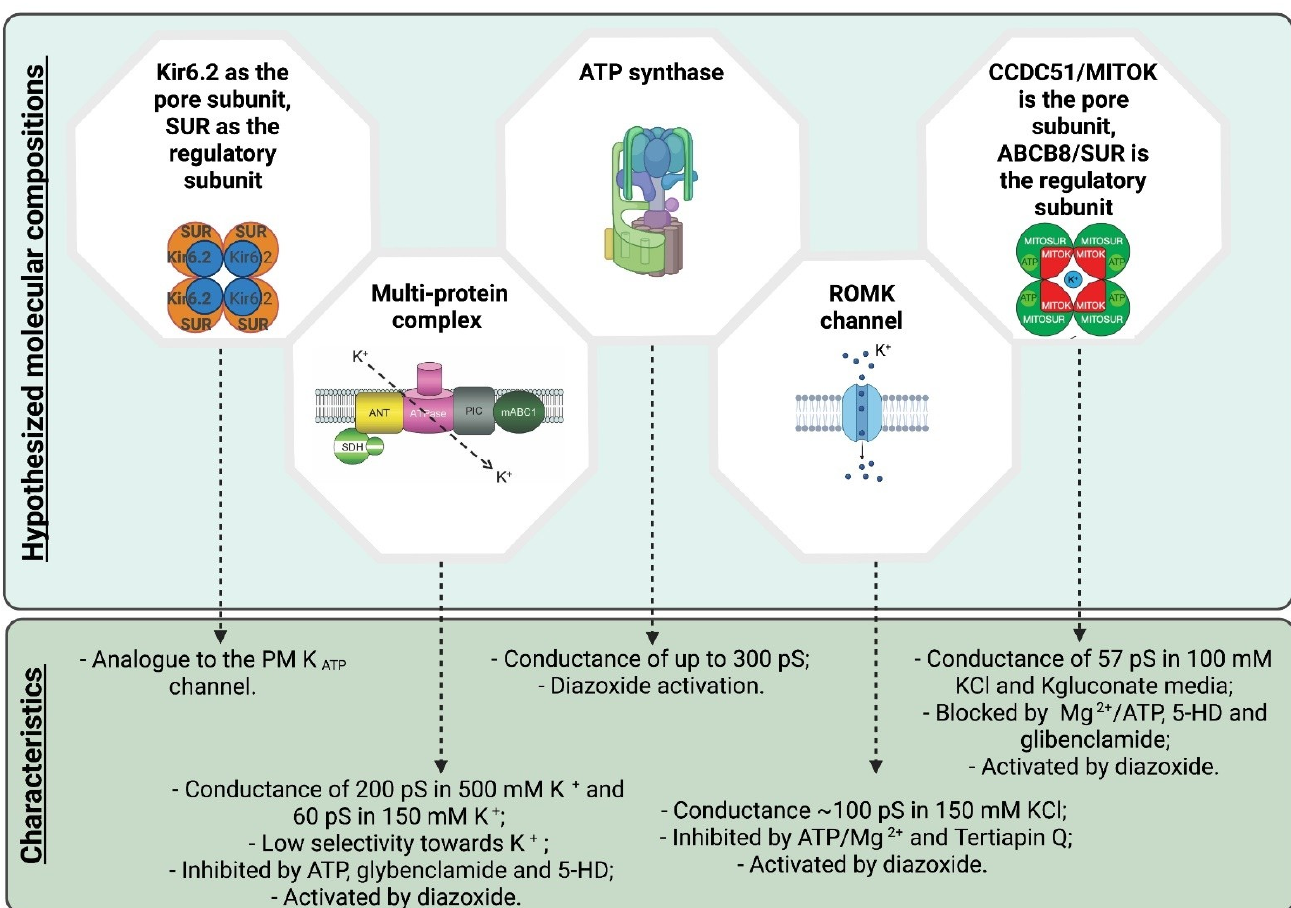
Figure 1. Schematic summary of the various hypotheses for the molecular composition of mitoKATP (see text for details). Created with BioRender.com (accessed on 22 June 2021).